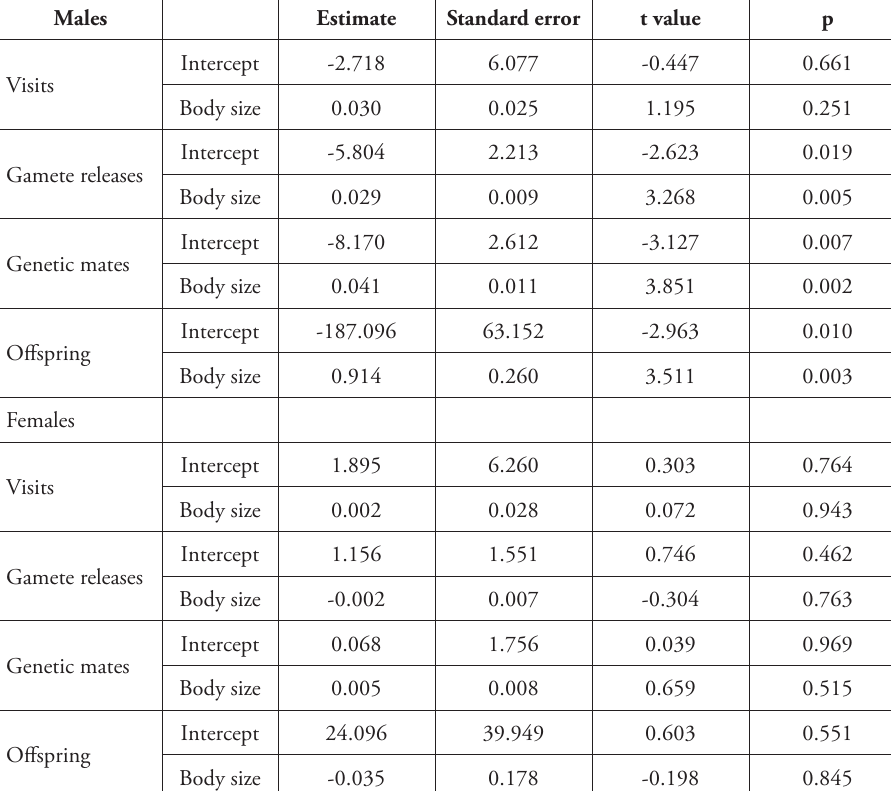
Table 2. Summary for the linear regressions of male and female brown trout body size on the number visits to or from individuals of the opposite sex observed on video recordings, number of gamete releases observed on video recordings, number of mates inferred from genetic assignation of offspring, and num- ber of offspring genetically